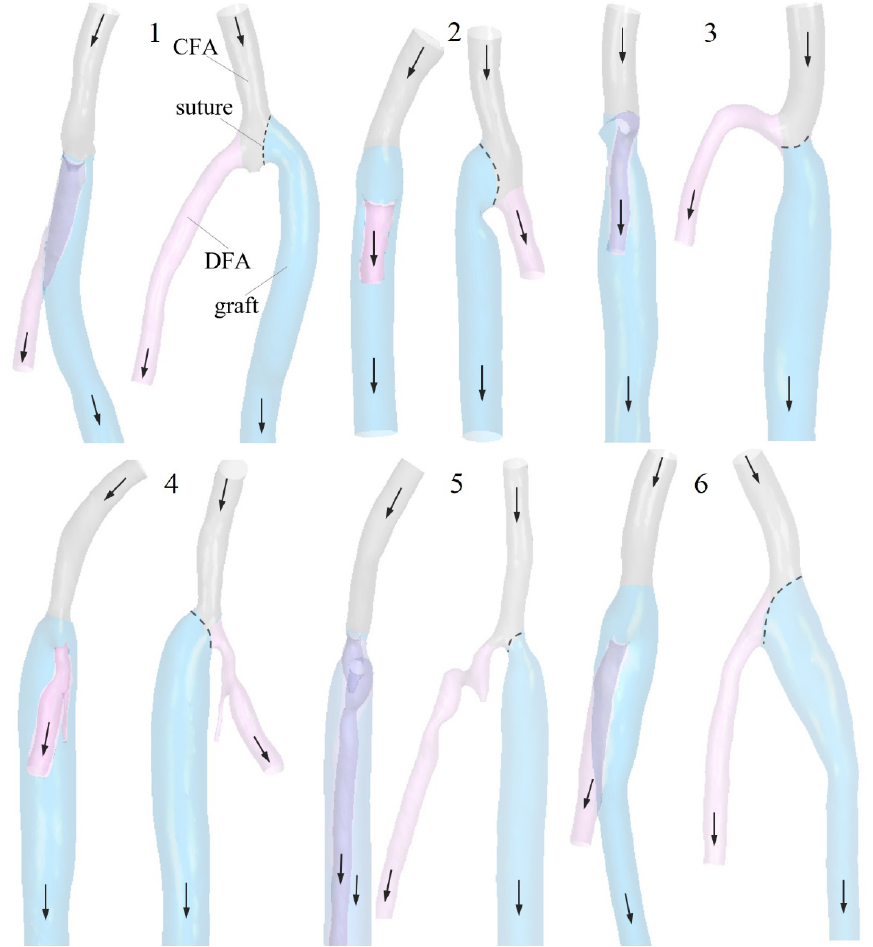
Figure 2. Geometric models based on MSCT data for six patients with femoral-popliteal bypass: right view ( left ) and front view ( right ). The common femoral artery (CFA) is marked in gray, the graft in blue and the deep femoral artery (DFA) in pink. Arrows indicate the blood flow direction. Geometric characteristics of the models and blood flow parameters are presented in Table 1. The parameter ∆ t defines the number of months after femoral-popliteal bypass surgery. Measurements of internal diameters of the vessels were carried out using MSCT and ultrasound B-mode images obtained with a Vivid S60N (GE Healthcare, Waukesha, WI, U.S.A.) ultrasound scanner by GE 9L-D linear transducer with a frequency of 2–8 MHz. In some models, the neointimal hyperplasia (NIH) was found. The scheme of de-